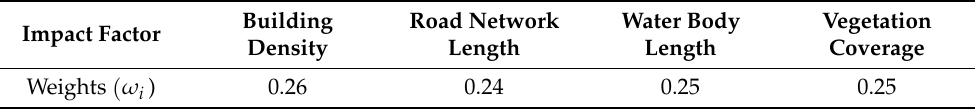
Table 1. Weight value of each index.